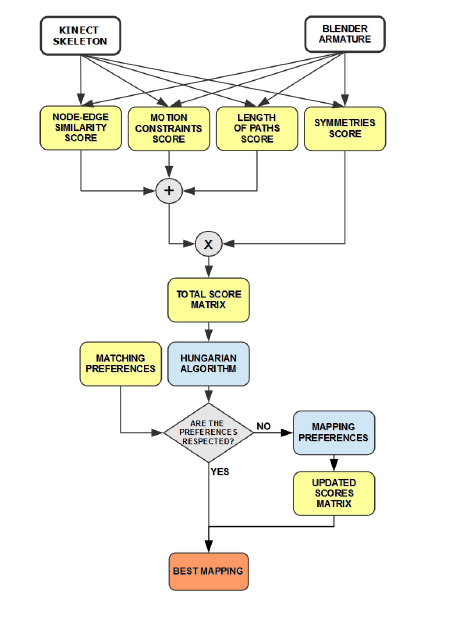
Figure 1. The first mapping algorithm described by a flow-chart.